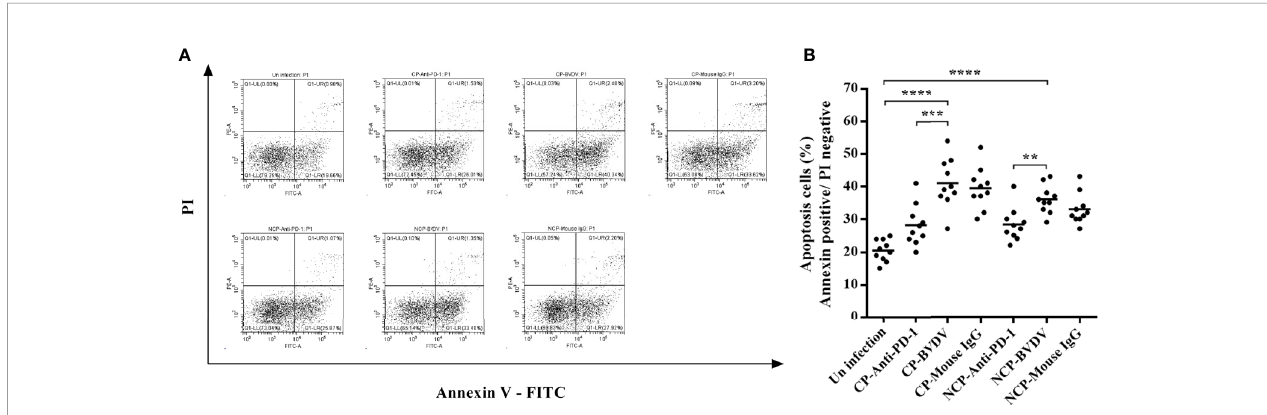
FIGURE 9 | Effect of PD-1 blockade on apoptosis of PBL from the BVDV-infected mice at day 7 of post-infection. (A) Flow cytometry analysis of apoptosis of PBL. (B) Statistical analysis of apoptosis of PBL. **** p < 0.0001, *** p < 0.001, ** p < 0.01. The animals were assigned into 7 experimental groups, including the mock- infected group, CP BVDV-infected group, CP BVDV+anti-PD-1 group, CP BVDV+mouse IgG group, NCP BVDV-infected group, NCP BVDV+anti-PD-1 group, and NCP BVDV+mouse IgG group. CP and NCP BVDV-infected mice were used as the controls. Data are presented as mean ± SD (n = 10 per group) and analyzed using one-way ANOVA.